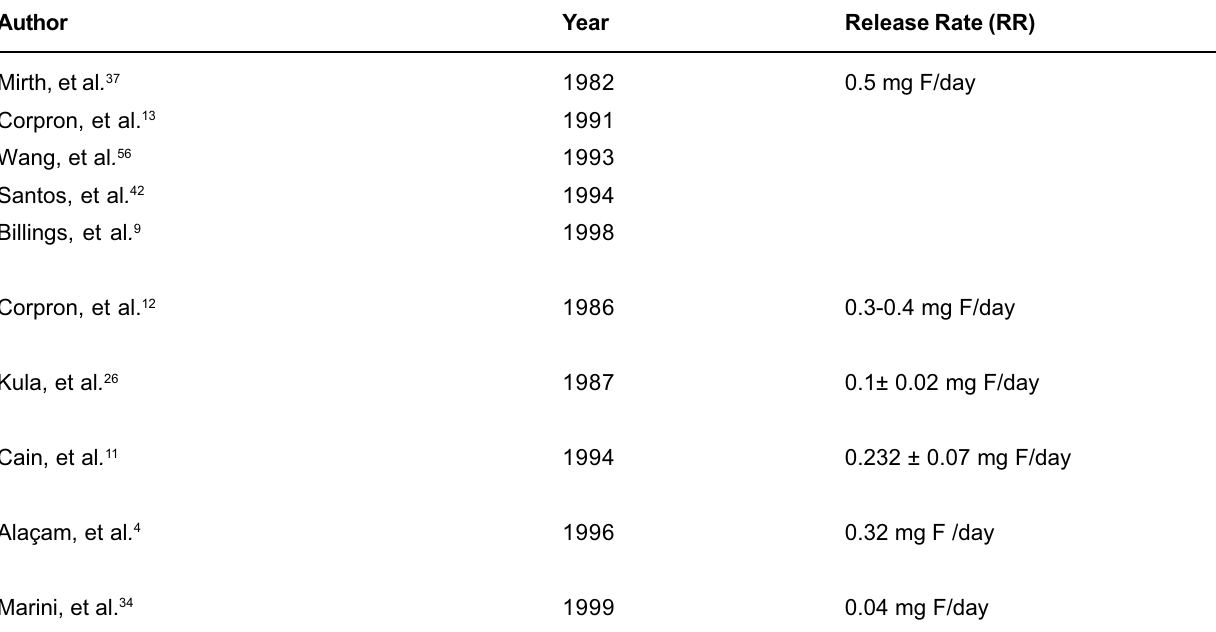
TABLE 2- Reported release rates of copolymer devices in clinical studies